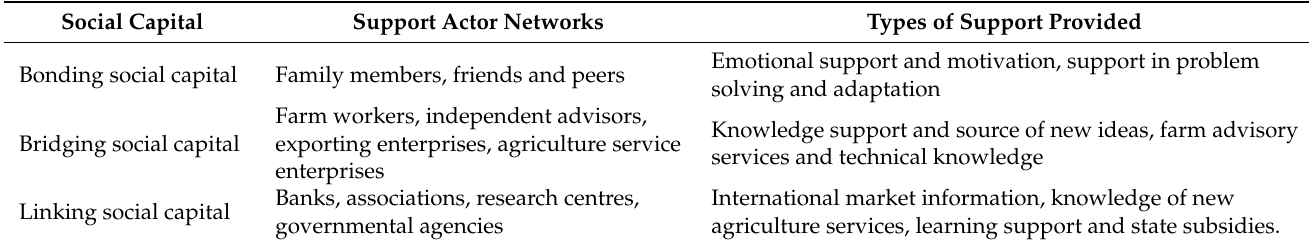
Table 4. Types of social capital, actors and sorts of support